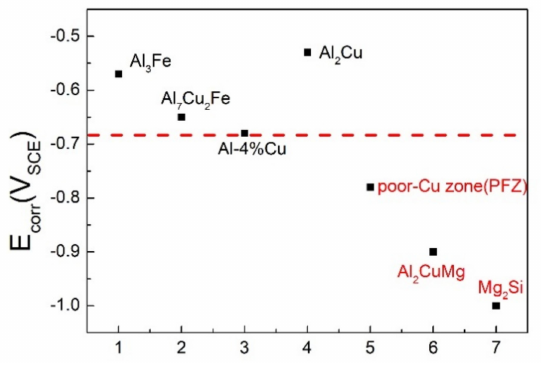
Figure 14. The electrode potential of fcc Al, copper-poor zone, and particles.